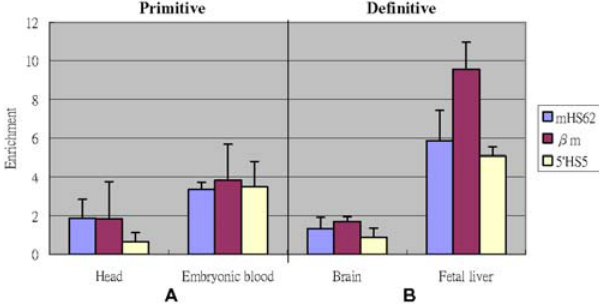
Figure 6. CTCF-ChIP assay analysis of the binding of CTCF protein to the mouse HS62 (mHS62), b m and human 5 9 HS5 in the primitive (A) and definitive (B) stage. Fold enrichment of the test sequence in bound with CTCF versus input/starting material is shown on the y axis.